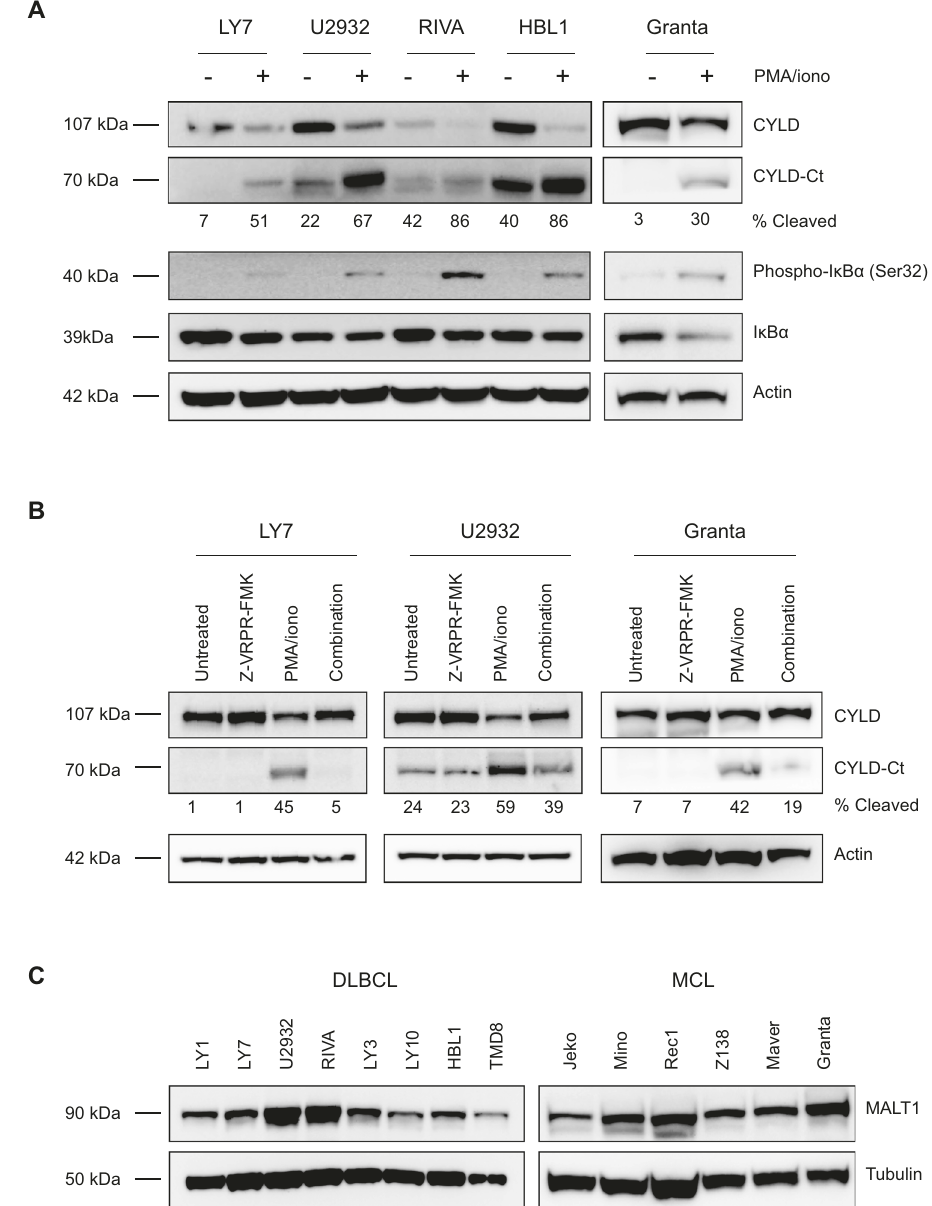
Fig. 2 CYLD is cleaved by MALT1 protease. A Immunoblot analysis of CYLD cleavage following treatment with phorbol myristate acetate (PMA) and ionomycin. Cells were treated for 1 h with PMA (50 ng/ml) and ionomycin (1 µg/ml) as indicated. Phosphorylated IkB α (Ser32) and total IkB α were used as positive controls for PMA/ionomycin stimulation; β -actin was used as a loading control. B Immunoblot analysis of CYLD cleavage following treatment with PMA/ionomycin and/or MALT1 inhibitor Z-VRPR-FMK. Cells were pre-treated for 1 h with 75 µM Z-VRPR-fmk before incubation for 1 h with PMA (50 ng/ml) and ionomycin (1 µg/ml) as indicated. β -actin was used as a loading control. C Immunoblot analysis of MALT1 expression in DLBCL and MCL cell lines. β -tubulin was used as a loading